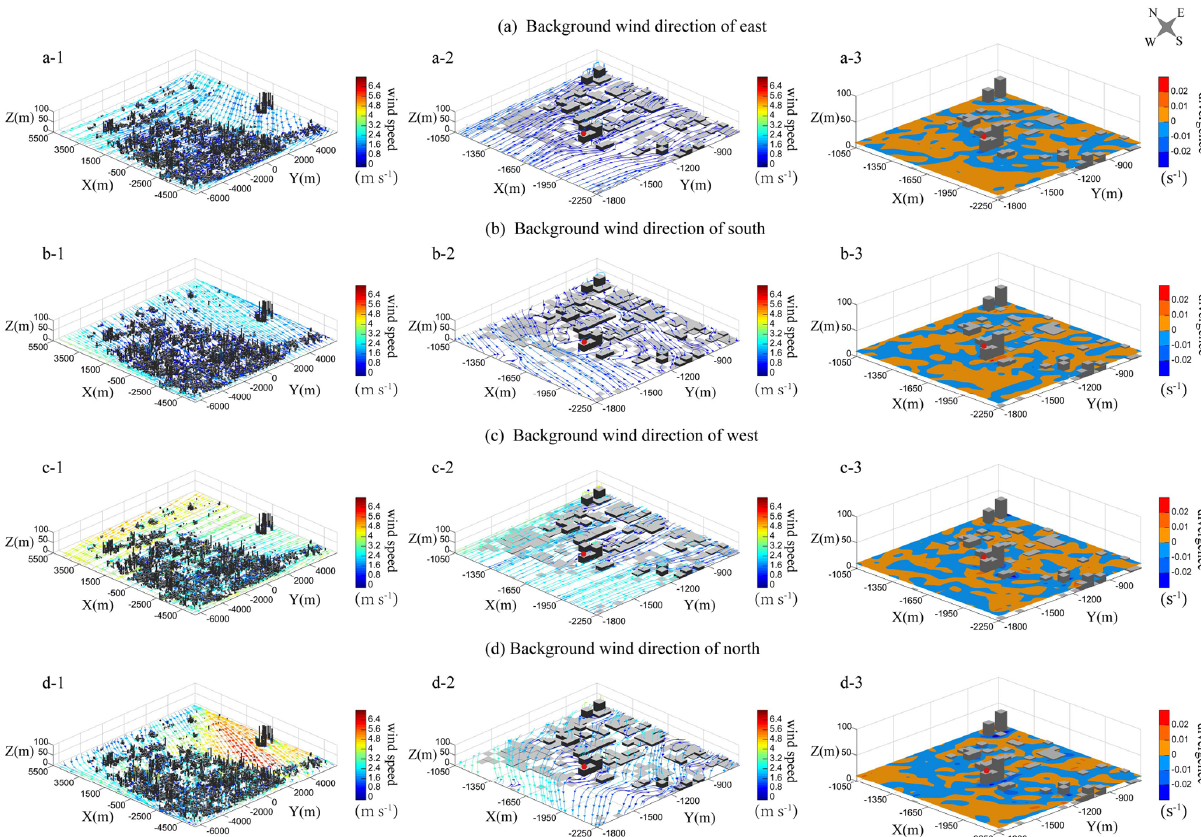
Figure 6. The wind field streamlines and divergences under the background wind directions of east (a) , south (b) , west (c) , and north (d) . The BSC monitoring site is marked with a red